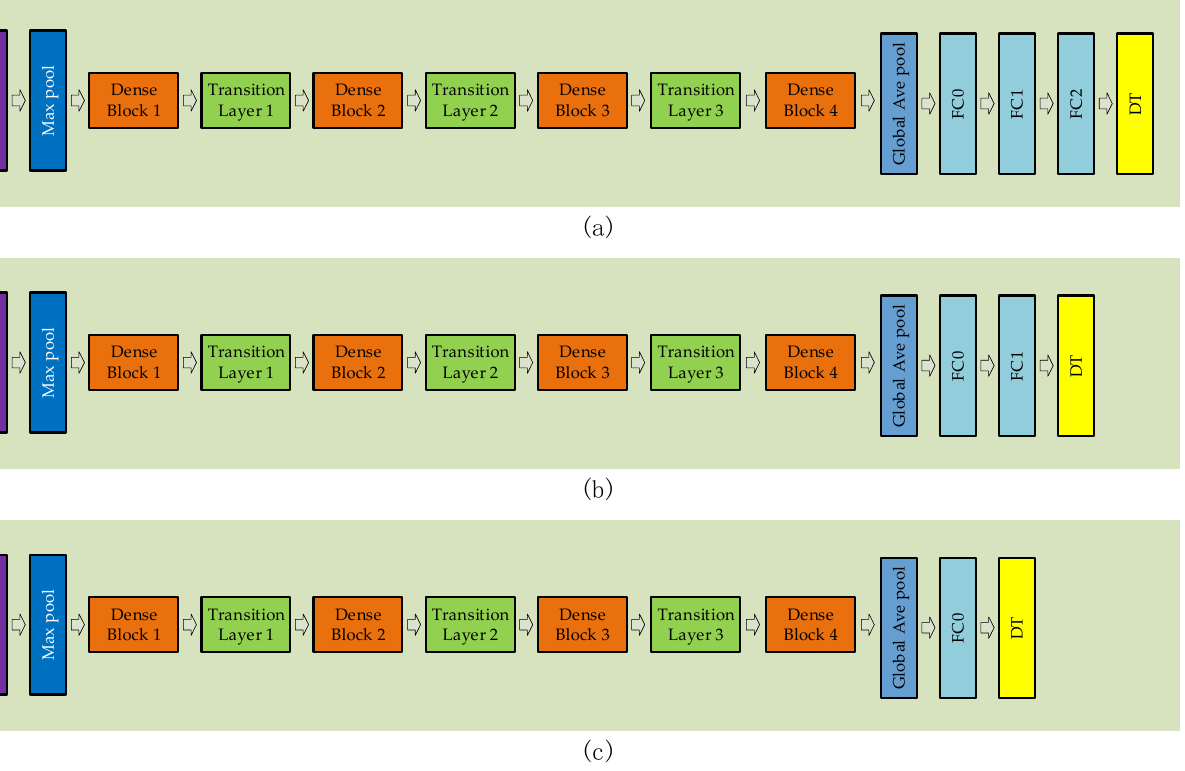
Figure 10. Structure of DenseNet-DT when DT is connected to different fully connected layers.